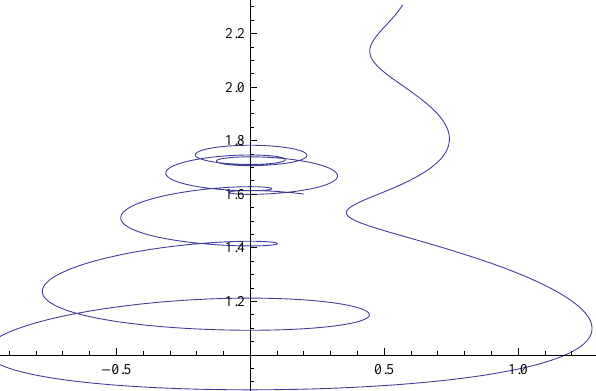
Figure 2. The atom bounces to infinity.